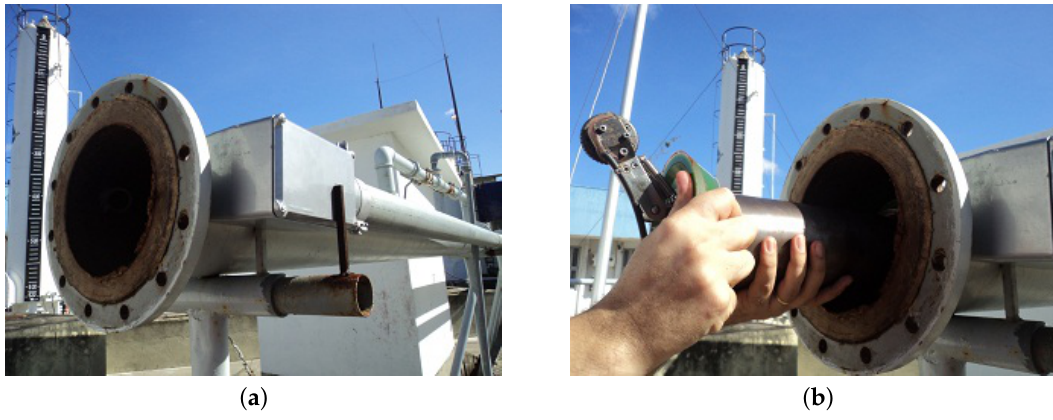
Figure 9. Procedures with the prototype PIG in the φ 8” launcher. ( a ) opening the φ 8” launcher cover; ( b ) inserting the prototype PIG in the φ 8” launcher. Source: By